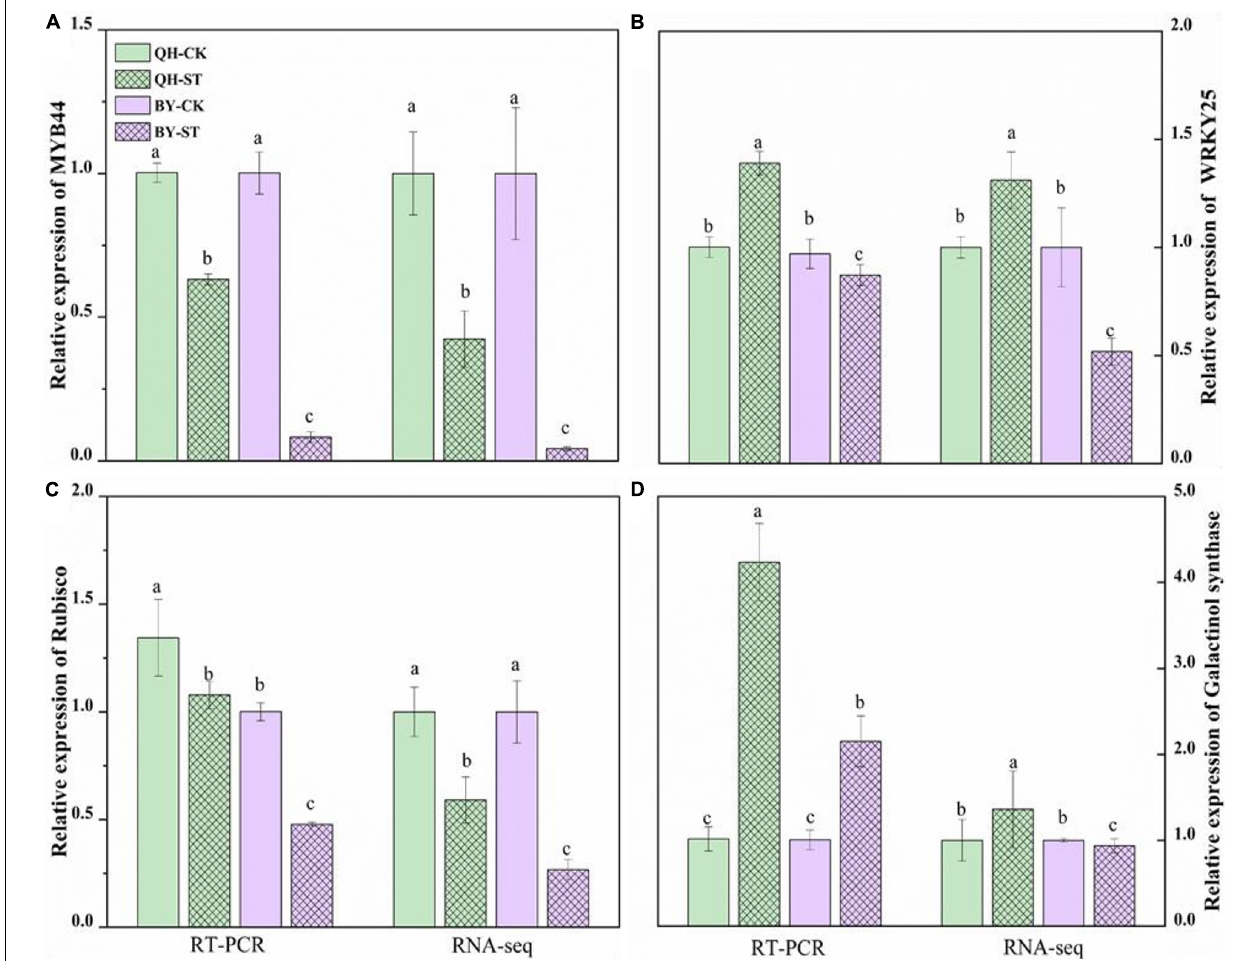
FIGURE 9 | Relative expression of MYB44, WRKY25, Rubisco and galactinol synthase in the leaves of Qinghua45 (QH) and Biyuchunhua (BY). (A) MYB44, (B) WRKY25, (C) Rubisco, and (D) galactinol synthase of Chinese cabbage under salt stress conditions. Data are the means of three replicates ± SD, and the different letters (a–d) indicate a significant difference at P ≤ 0.05 according to Duncan’s